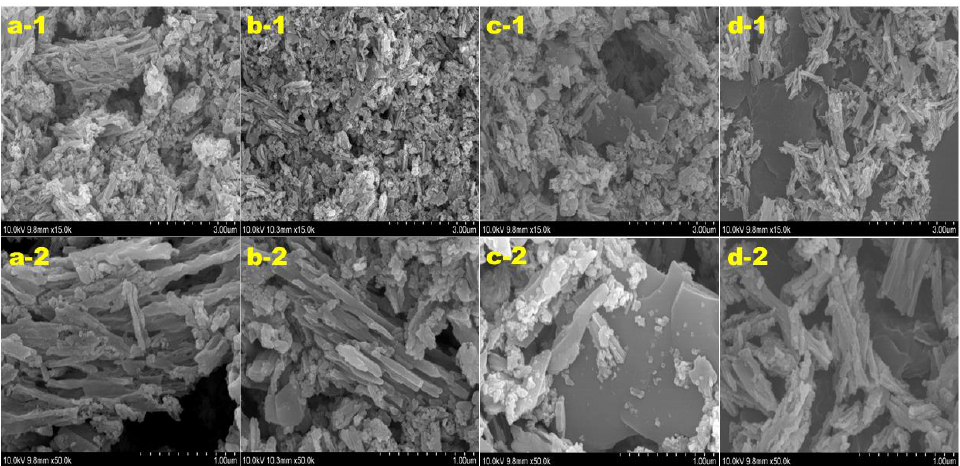
Figure 3. SEM analysis of the electrocatalysts; low and higher magnification of: ( a-1 , a-2 ) CeO 2 , ( b-1 , b-2 ) CeO 2 –GO-1, ( c-1 , c-2 ) CeO 2 –GO-2, and ( d-1 , d-2 ) CeO 2 –GO-3.